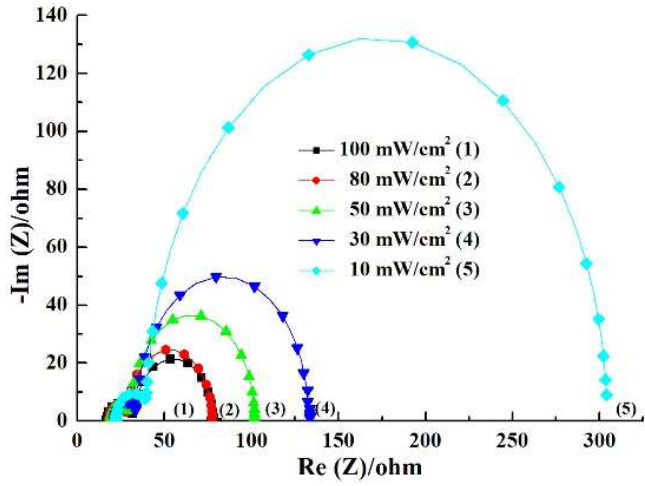
ff erent illuminations.